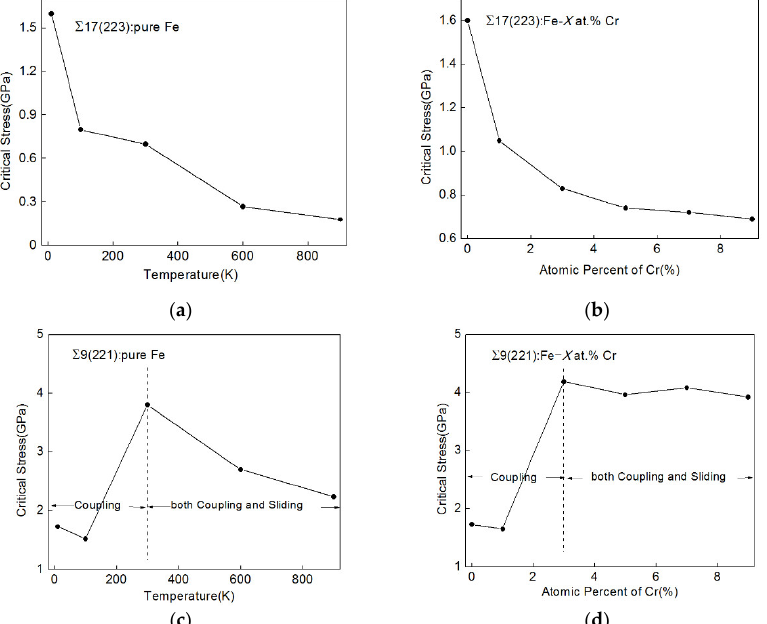
Figure 10. Critical stress of migration of ( a ) the Σ17(223) GB in pure Fe at five different temperatures and ( b ) the Σ17(223) GBs in pure Fe and Fe-X at.% Cr alloys (X = 1, 3, 5, 7, and 9) at 10 K and ( c ) the Σ9(221) GB in pure Fe at five different temperatures, and ( d ) the Σ9(221) GBs in pure Fe and Fe-X at.% Cr alloys (X = 1, 3, 5, 7, and 9) at 10 K. Figure 10c,d display how the critical stress of migration of the Σ9(221) GB changes over temperature and the concentration of Cr. When the concentration of Cr is increased to 3%, the critical stress of GB migration increases sharply as a result of the occurrence of GB sliding, as discussed in section 3.2. A similar phenomenon can be observed in the